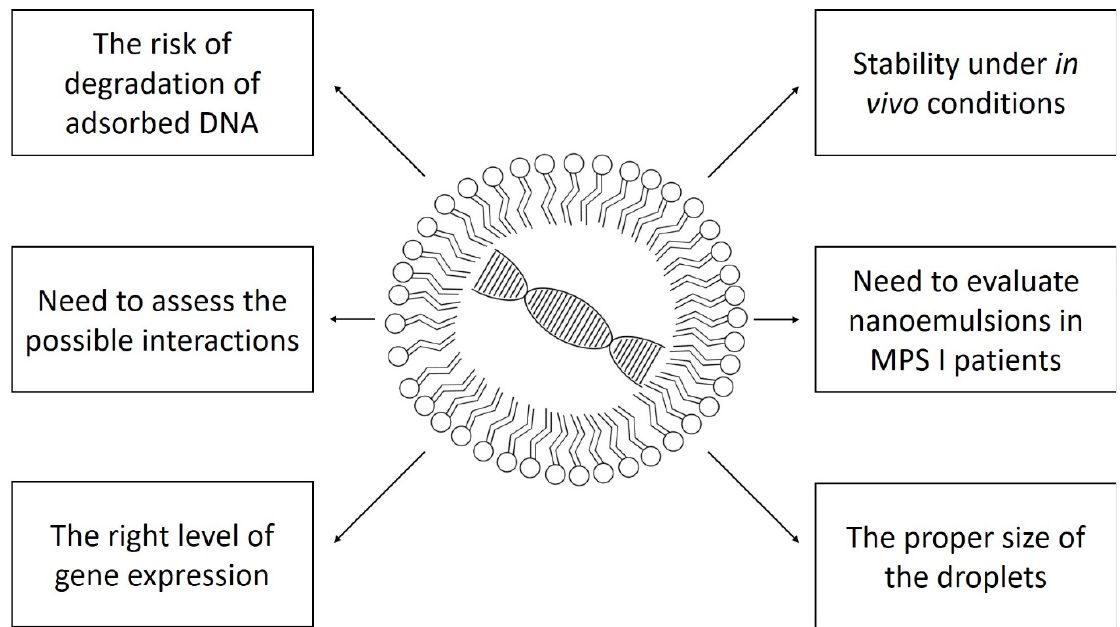
Figure 1. The most important problems standing in the way to the widespread use of nanoemulsion gene therapy in mucopolysaccharidosis type I.